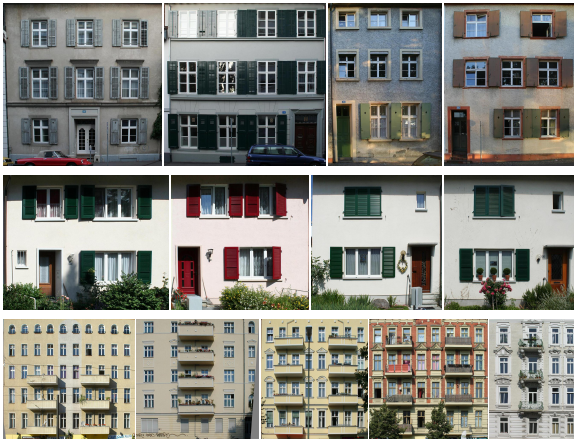
Figure 2: Sample images from used datasets. From top to bottom: Basel old town, Basel row houses, City houses with balconies. which was shown by Ortner et al. (2003) and completes Alg. 1.